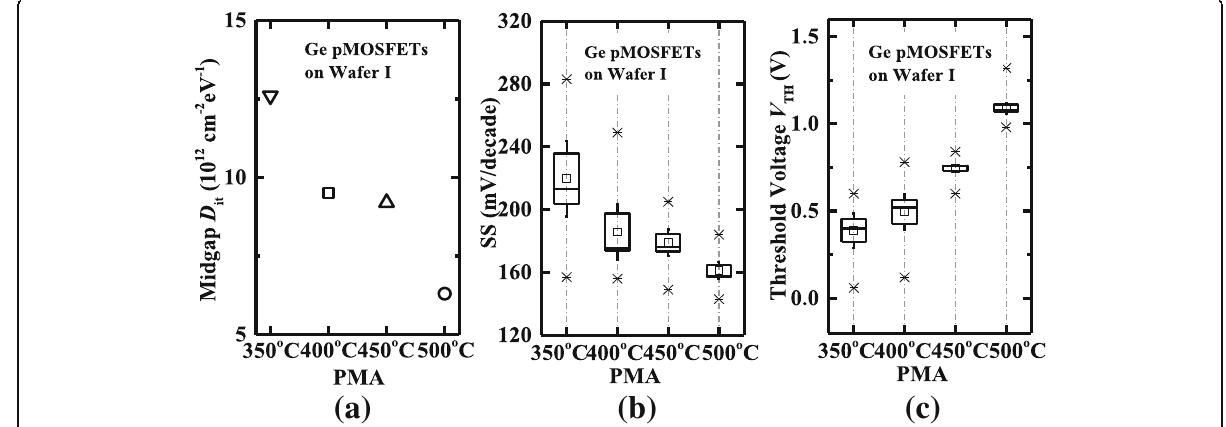
Fig. 4 Comparison of a midgap D it , b SS, and c V TH for Ge pMOSFETs on wafer I with the PMA at 350, 400, 450, and 500 °C